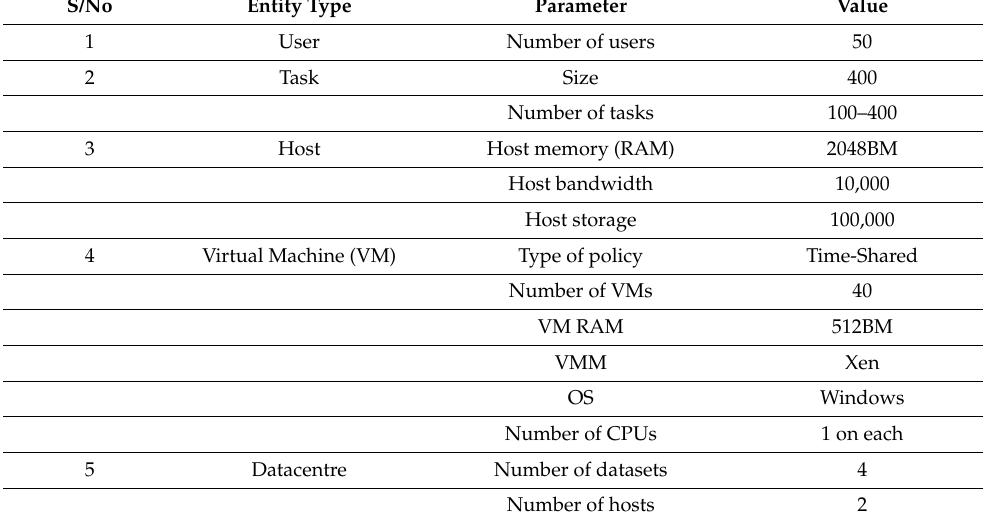
Table 2. Simulation setup.